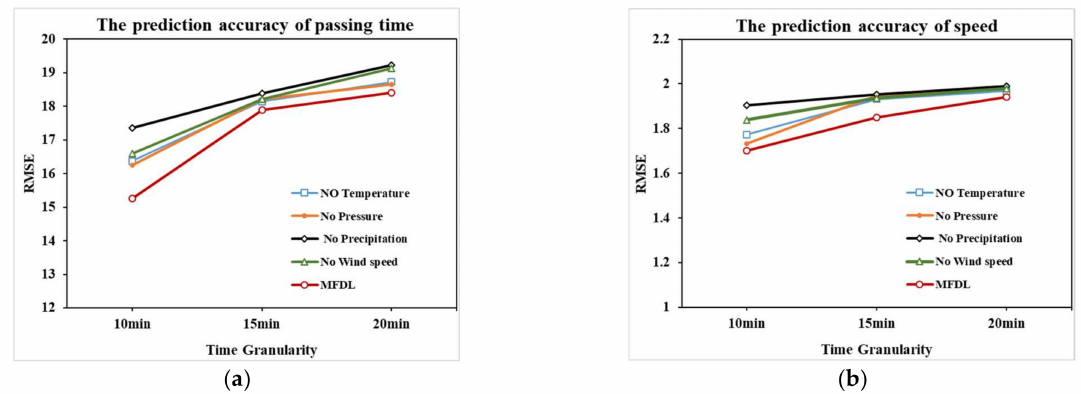
Figure 19. Influence of weather factors on prediction accuracy: ( a ) the prediction accuracy of the passing time; ( b ) the prediction accuracy of